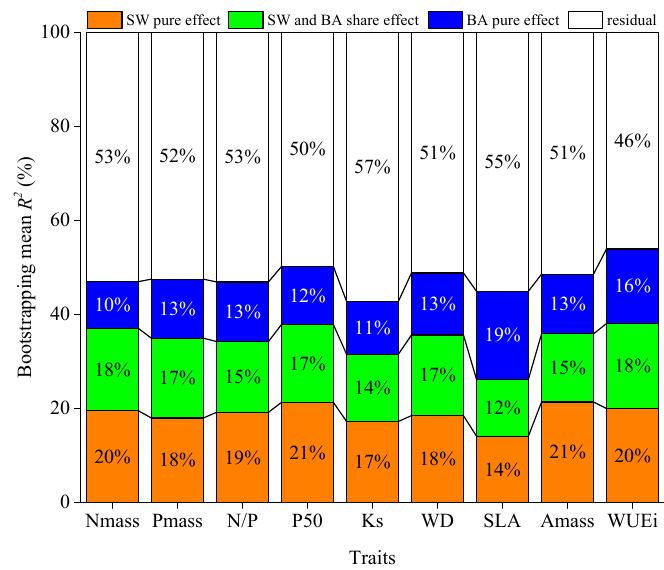
Figure 4. Bootstrapping mean pure and shared effects of SW (dry season soil water content in the top 50 cm layer) and BA (basal area) on quadrats’ trait value changes as derived from variation partitioning analysis and bootstrapping method. Nmass, leaf nitrogen concentration per unit mass; Pmass, leaf phosphorus concentration per unit mass; N/P, leaf nitrogen to phosphorus ratio per unit mass; P50, the pressure causing 50% loss of stem hydraulic conductivity; Ks, sapwood-specific hydraulic conductivity; WD, sapwood density; SLA, specific leaf area; Amass, maximum CO 2 assimilation rate per unit mass; WUEi, instantaneous photosynthetic water-use efficiency. More information is provided in Table A3.